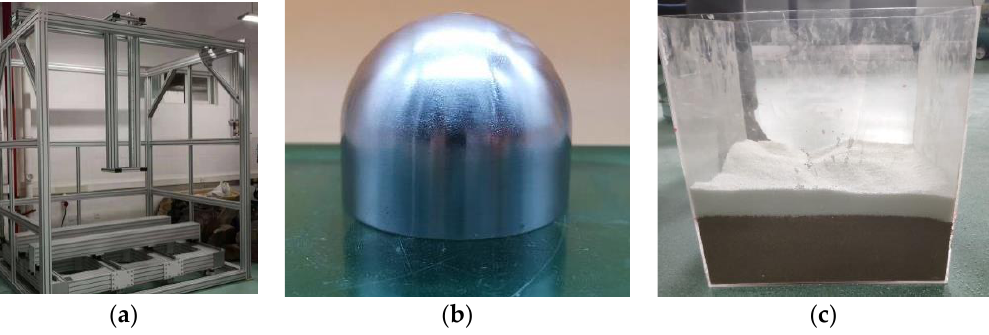
Figure 5. Test instruments. ( a ) Impact test device; ( b ) the falling hammer; ( c ) the acrylic box.